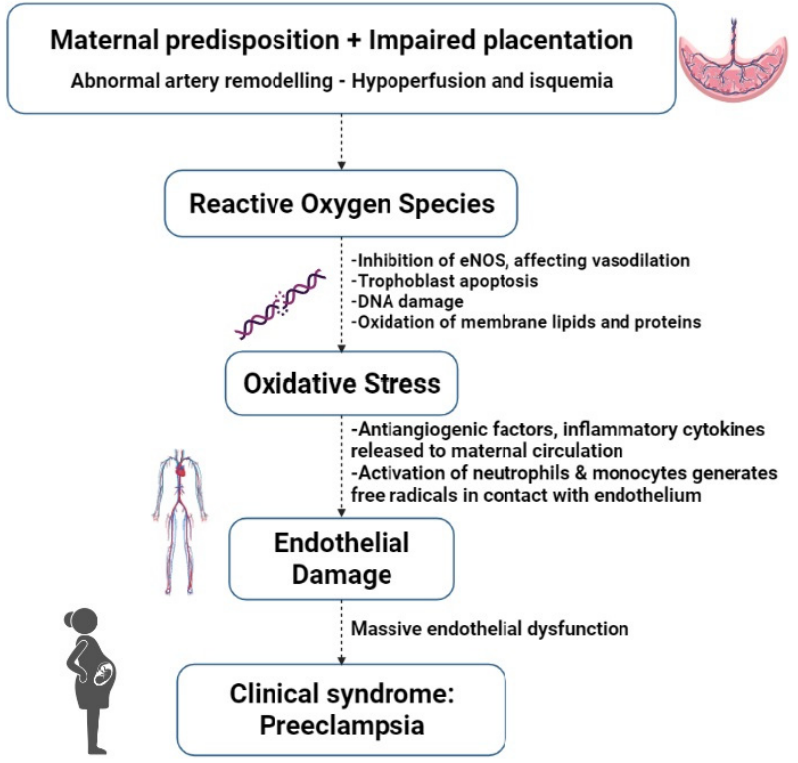
Figure 2. Main events in the development of preeclampsia. eNOS = endothelial nitric oxide syn- thase.